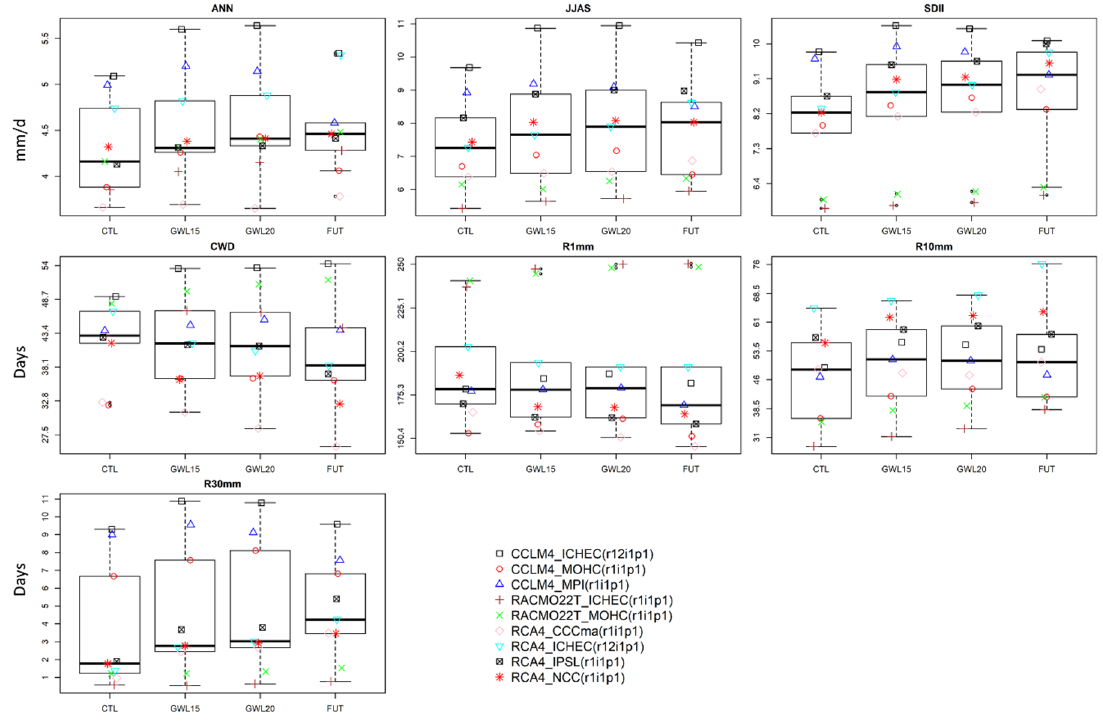
Figure 5. As in Figure 4 but for WA-S region.